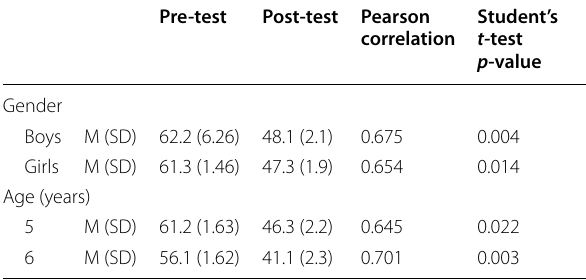
Table 2 Statistical evaluation results of ASQ:SE for pre- and post- tests (for each test component)